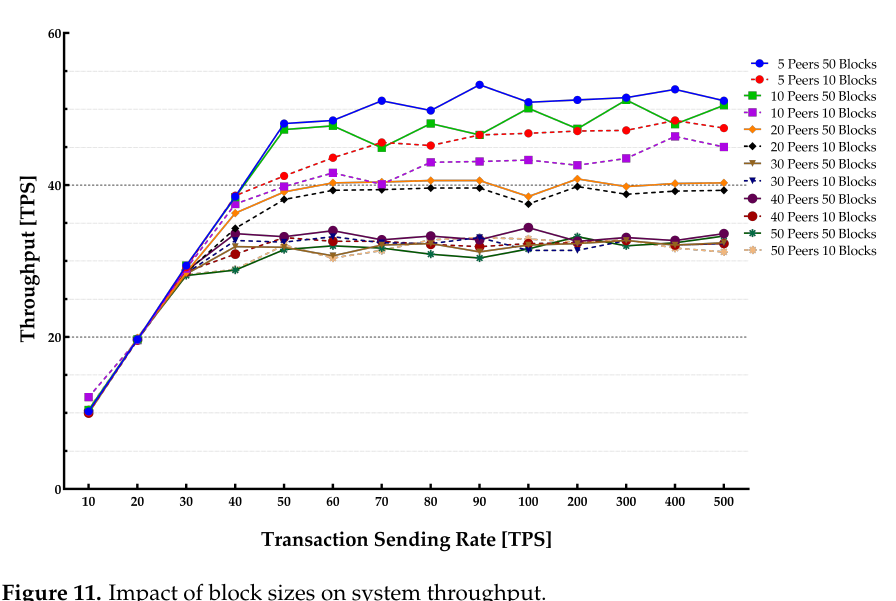
Figure 11. Impact of block sizes on system throughput.